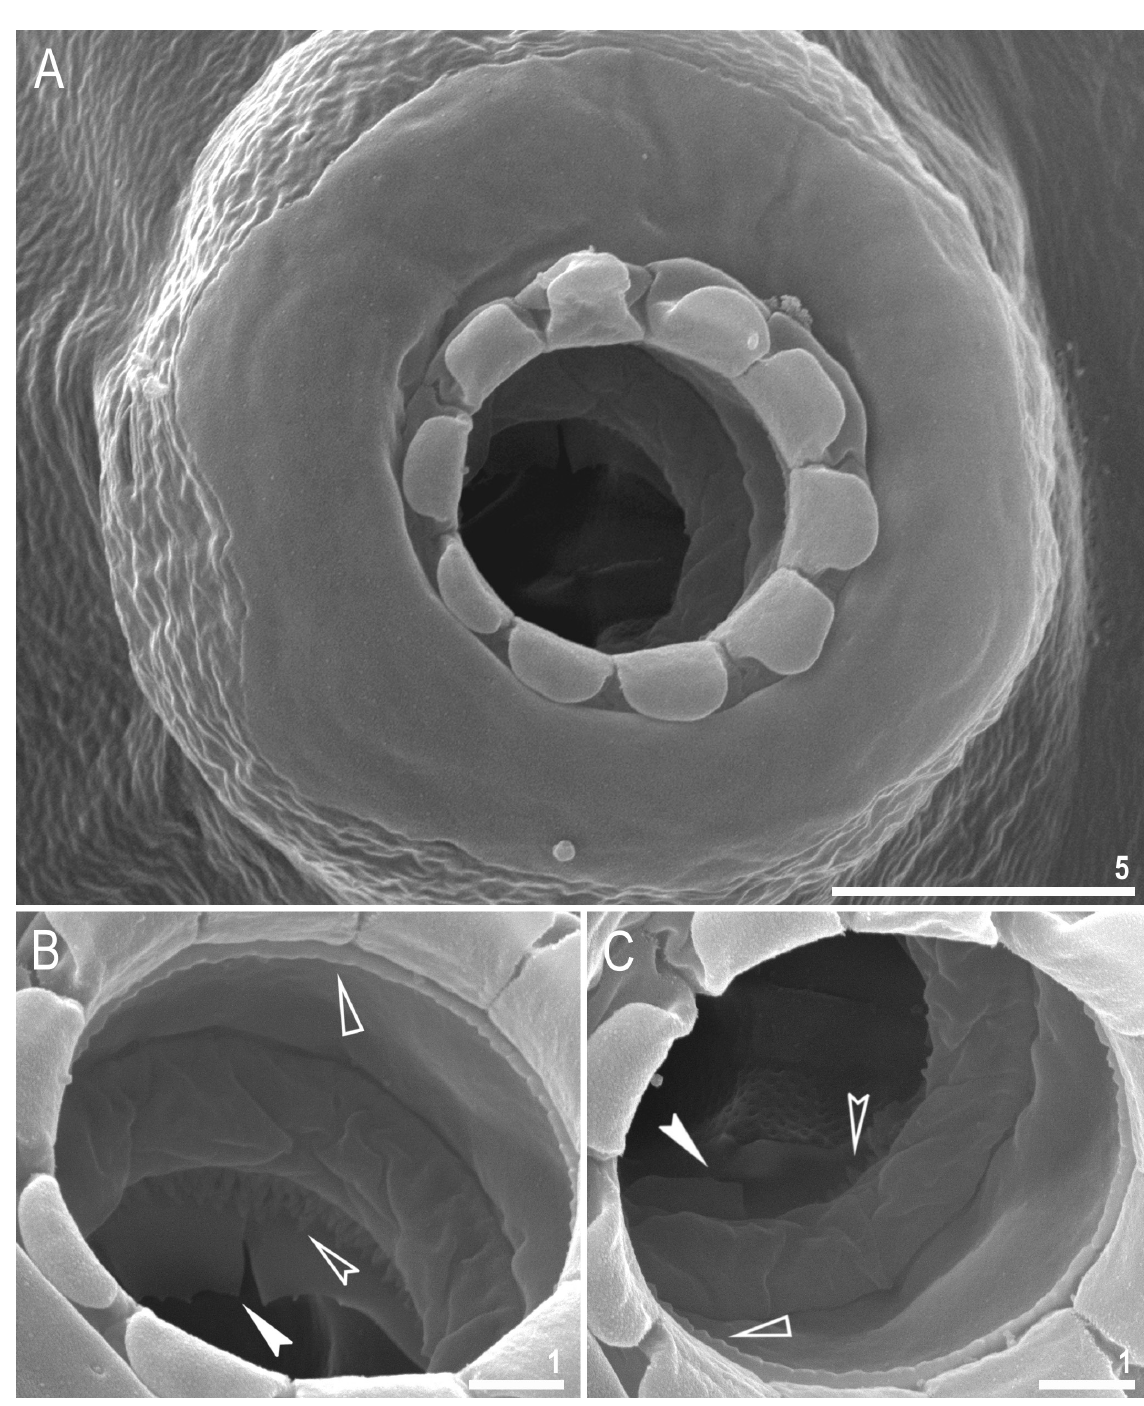
Fig. 5. Macrobiotus noongaris sp. nov., mouth opening and the oral cavity armature seen in SEM (paratype, IZiBB). A . Mouth opening with peribuccal sensory lobes and ten peribuccal lamellae. B–C . The oral cavity armature of a single paratype seen in SEM from different angles, in dorsal (B) and ventral (C) views, respectively. Empty flat arrowheads indicate the first band of teeth in the oral cavity, empty indented arrowheads indicate the second band of teeth in the oral cavity, filled indented arrowheads indicate the third band of teeth in the oral cavity. Scale bars in